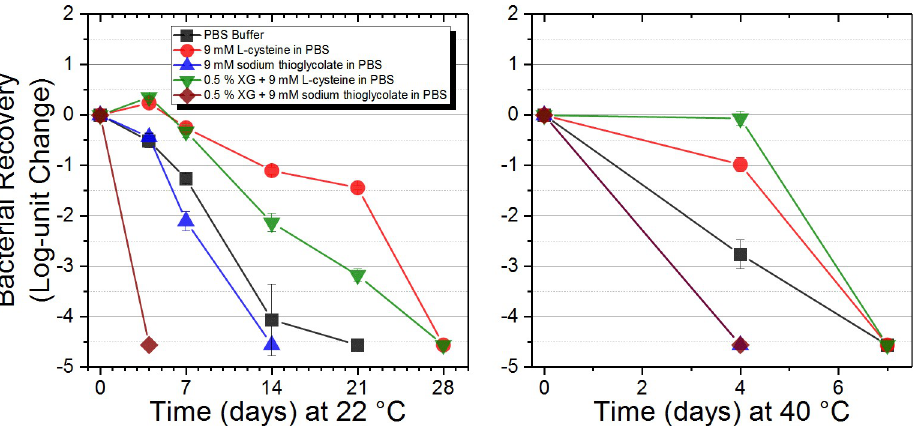
Fig 2. Screening sulfur sources at varying concentration to maintain F . novicida viability. XG and reference buffers were supplemented with two sulfur sources at varying concentrations. Viability of F . novicida in test matrices were spiked with ~10 4 CFU/mL and stored at 22 and 40˚C for 28 days. Data are the average of one biological replicate and two sample replicates plated in triplicate (n = 6